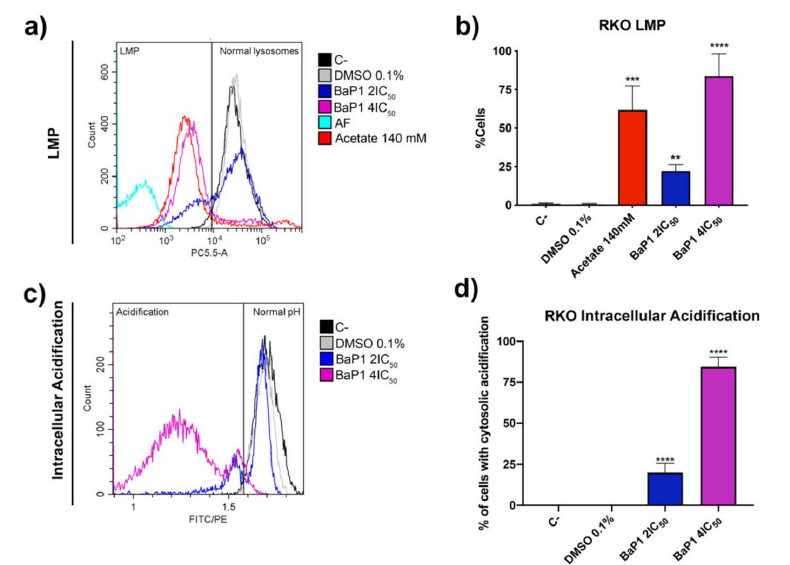
Figure 7. BaP1 lysosomal membrane permeabilization (LMP) and intracellular acidification induction. ( a ) Representative histograms of RKO LMP induction with AO after 48 h of exposure to BaP1 2 × IC 50 and 4 × IC 50 . Untreated cells (C-) and DMSO (0.1%) exposed cells were used as negative controls and acetate (140 mM) as positive control. ( b ) Quantification of the cells with LMP induction. Values are means with SD (n ≥ 3). Statistical analysis was performed by one-way ANOVA. ** p < 0.01, *** p < 0.001, **** p < 0.0001. ( c ) Representative histograms of RKO intracellular acidification with BCECF-AM after 48 h of exposure to BaP1 2 × IC 50 and 4 × IC 50 . Untreated cells (C-) and DMSO (0.1%) exposed cells were used as negative controls. ( d ) Quantification of the cells with